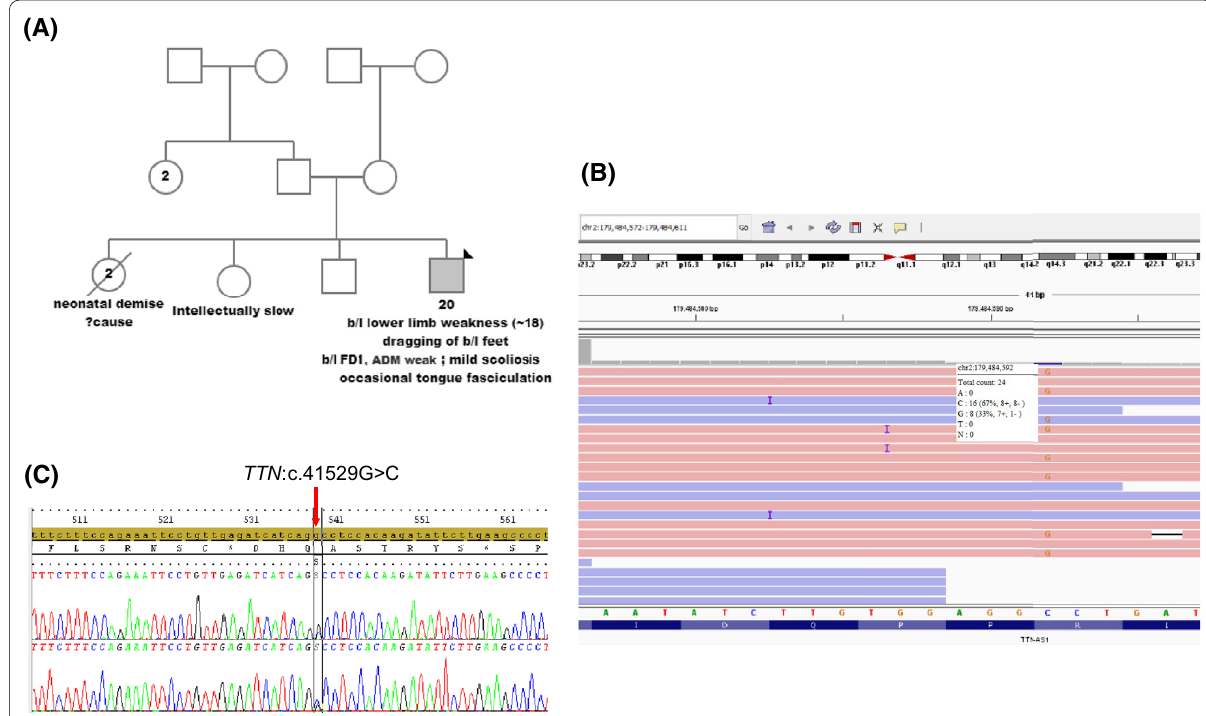
Fig. 1 A Pedigree of the probands’ family. B IGV plot showing the mutation region in WES data in the proband. Track comprises two parts: a histogram of the read depth and the reads as aligned to the reference sequence. Reads are colored according to the aligned strand (red strand; blue reverse strand). C Sanger sequence chromatogram showing a novel heterozygous missense variant in exon 200 of the TTN gene =